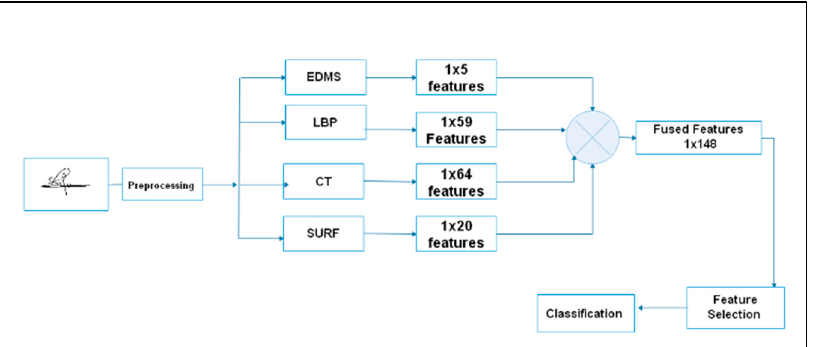
Figure 8. A strategy of feature fusion.